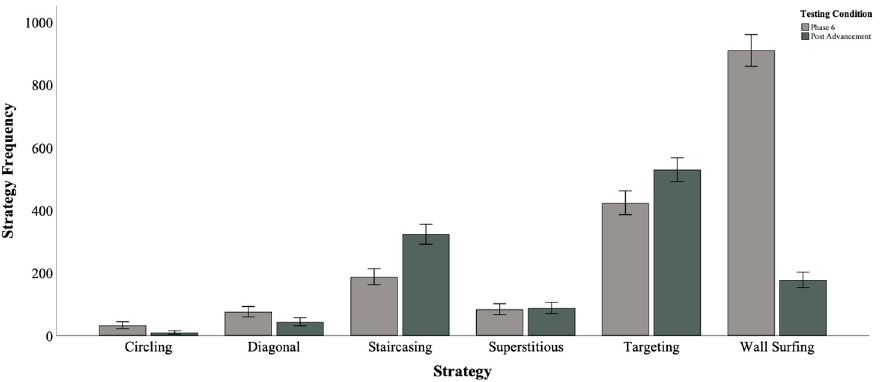
Figure 4. Frequency of strategies used by all sea lions in Phase 6 and Post-Advancement.